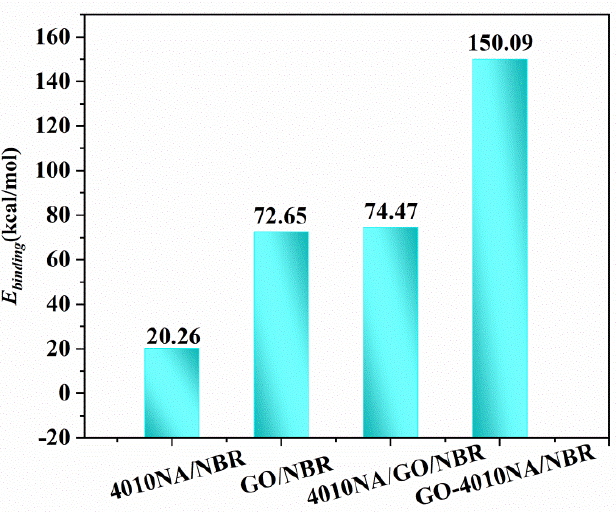
Figure 11. Binding energies of the different NBR composites.